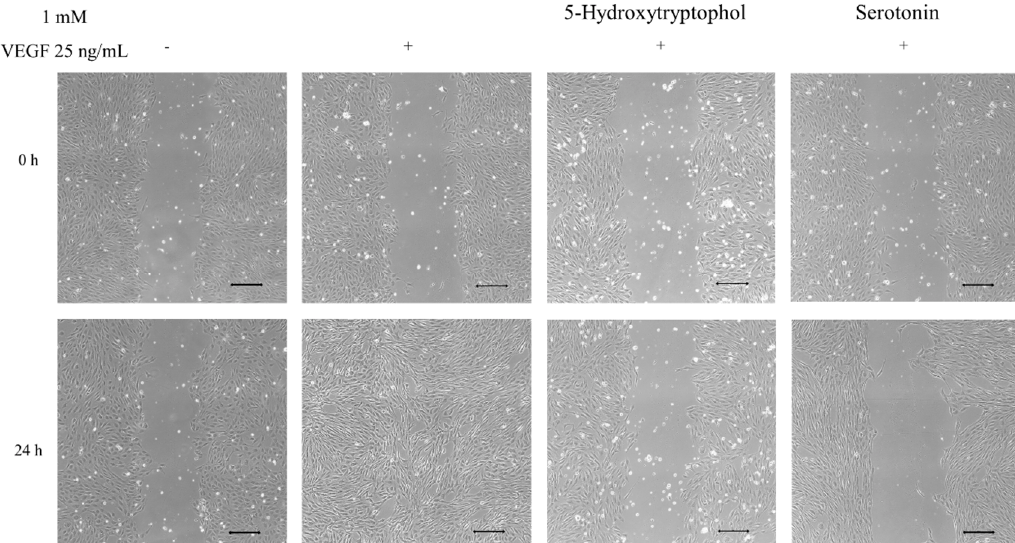
Figure 2. Serotonin and 5-hydroxytryptophol inhibited HUVEC migration. HUVECs were placed onto 50 mm imaging dishes and wounded. Then, they were incubated with 1 mM of 5-hydroxytryptophol and serotonin for 4 h and subsequently stimulated with VEGF. Representative photomicrographs were taken at 0 h and 24 h of VEGF stimulation. Scale bars: 200 µm.